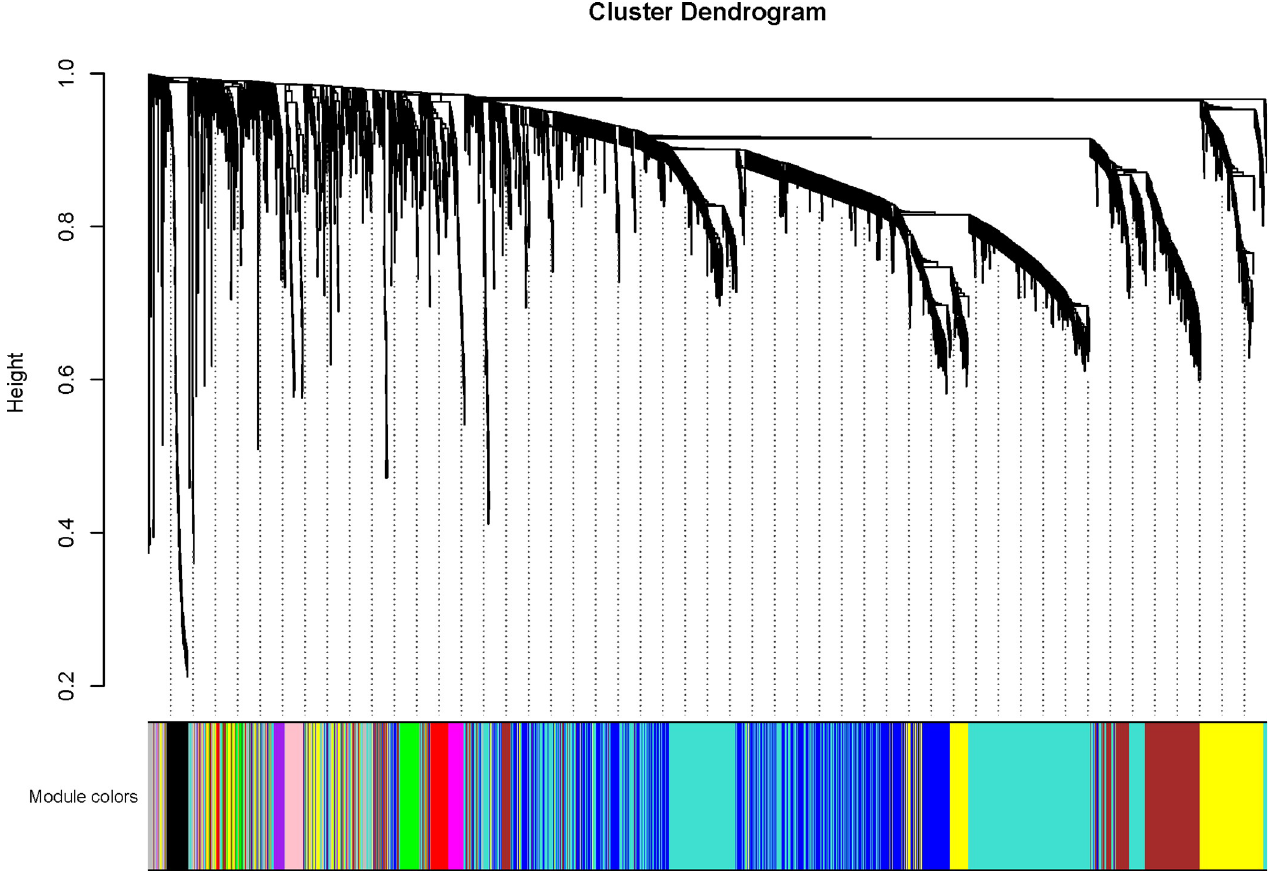
Fig 2. The cluster dendrogram of co-expression network. The genes and lncRNAs were clustered in 11 modules marked with various colors. Members (genes) in same module may participant in common biological process except for grey module which contained unrelated gene members. The largest module was turquoise module which contained 1189 members. And the smallest purple module contained the minimum 43